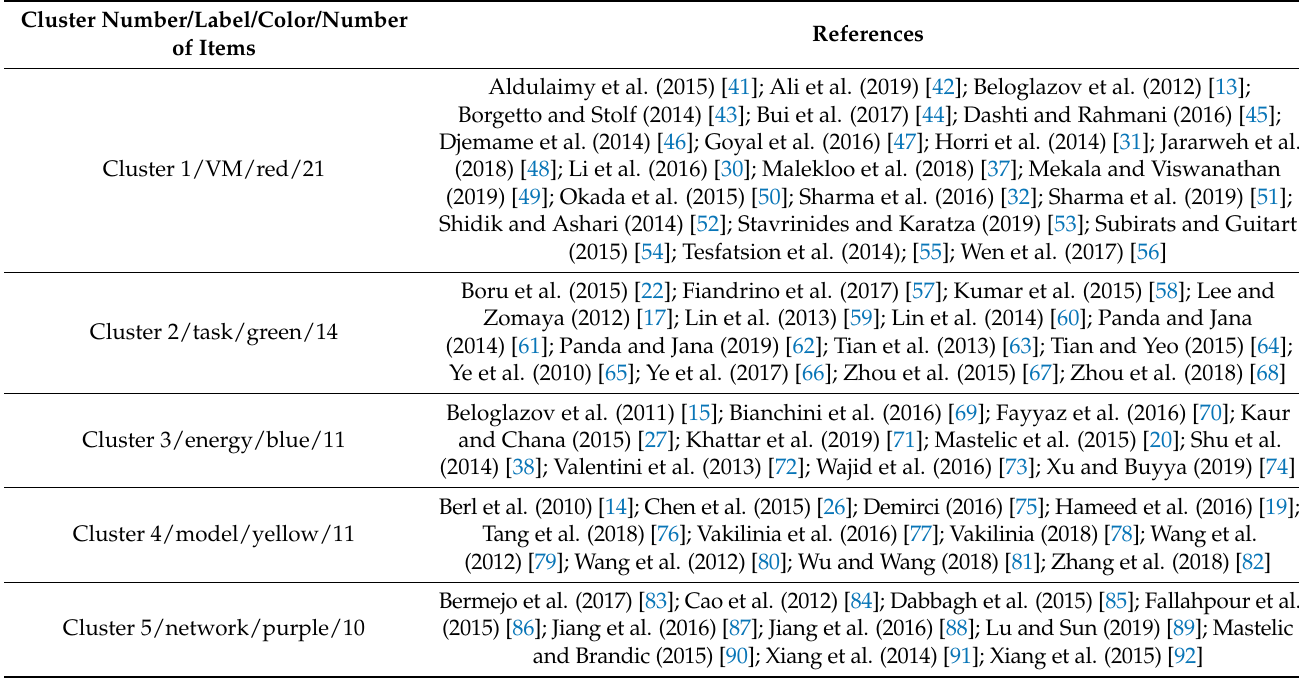
Figure 3. Direct citation analysis of the cloud computing energy efficiency research field (network visualization; weights— links). Source: authors’ own study. Data sourced from Scopus, analyzed with VOSviewer (5 September 2020). Table 4. Clusters of core references in the cloud computing energy efficiency research field.